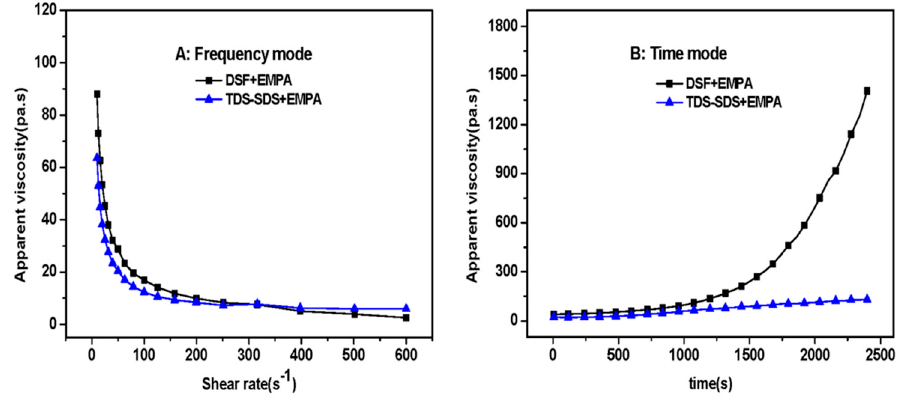
Figure 10. Apparent viscosity of various DSF-based adhesives, frequency mode ( A ) and Time mode ( B ).